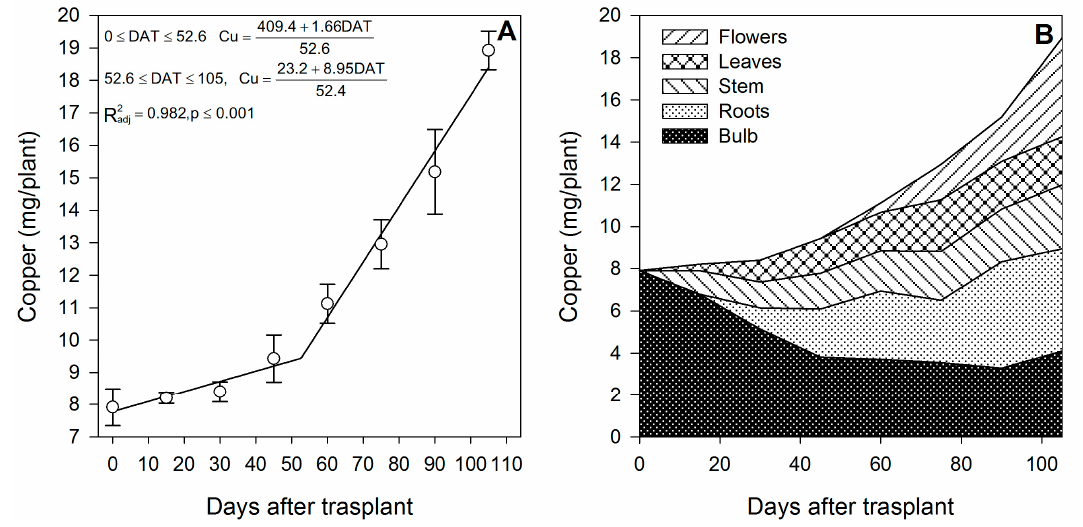
Figure 11. Copper accumulation in lilium: ( A ) Segmented analysis of copper accumulation over the growing season; ( B ) Copper distribution in the lilium plant parts. Day 0 = transplant day, days 0 to 15 = sprouting and initial vegetative growth, days 15 to 60 = rapid vegetative growth plus flower buds formation, days 60 to 105 = blooming. DAT = days after transplant.